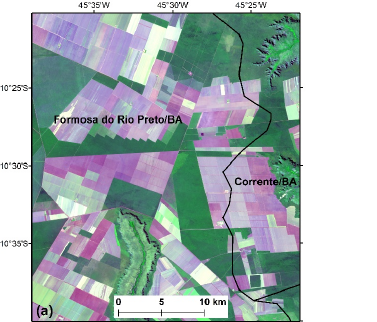
Figure 1. Location of Brazil in the American continent (inset figure) and location of Mato Grosso (MT) State in Brazil. Brazil and Mato Grosso State correspond to the two selected study areas of this paper. The country is divided into five regions: North, Northeast, Midwest, South, and Southeast. Pie graphs show the percentages of six major national crop types in Brazil by region. Source: IBGE [31].